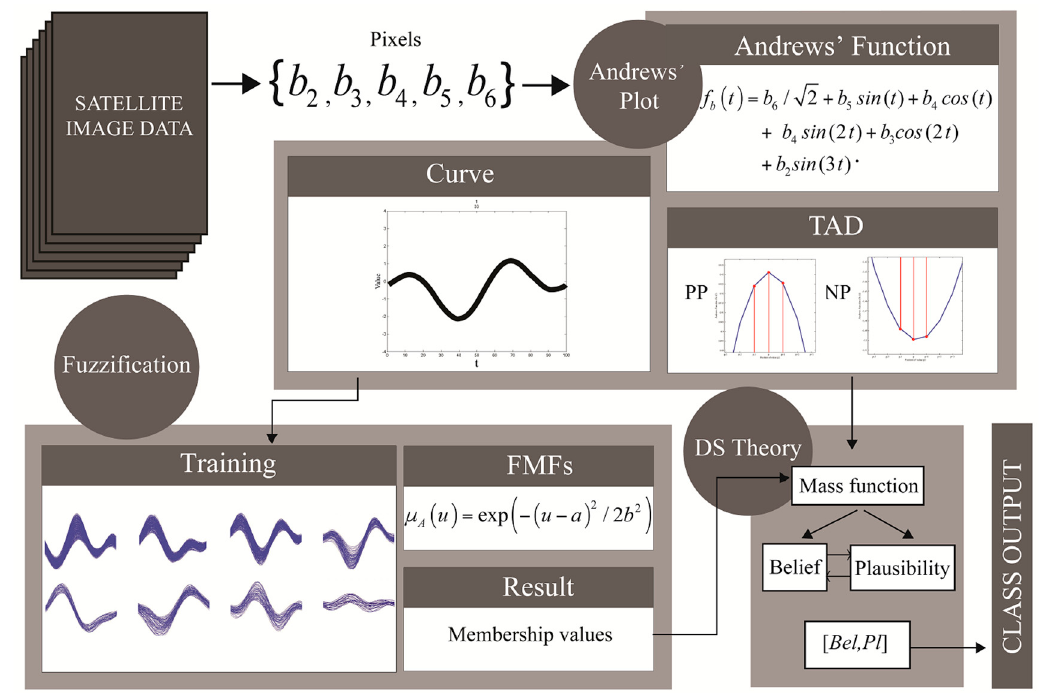
Figure 5. Overall analysis process. First, an Andrews’ function is applied to pixels from the satellite image data to obtain the curves and TAD. Second, the training curves are selected and used in fuzzification to obtain the membership values of each class. Finally, the membership values and TAD are used as parameters in DS theory. The final class decisions are determined by the obtained belief interval.